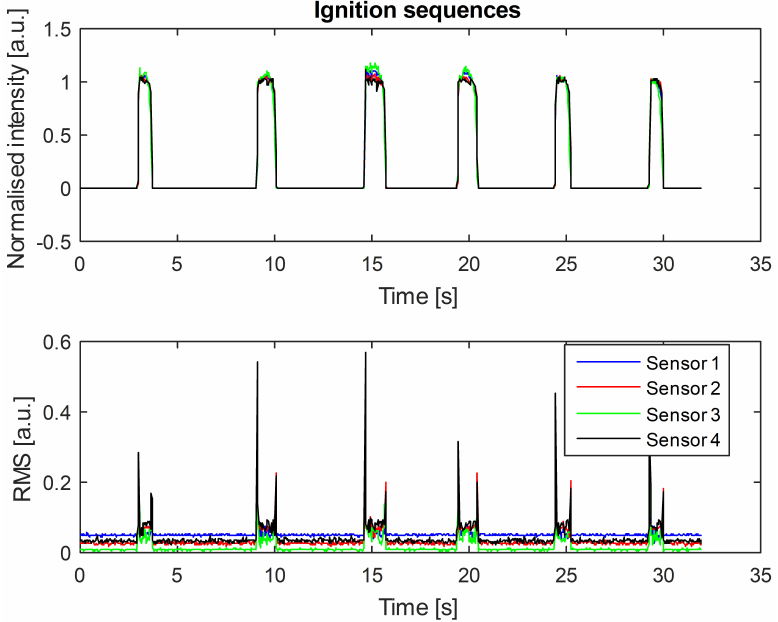
Figure 15. Ignition monitoring using 4